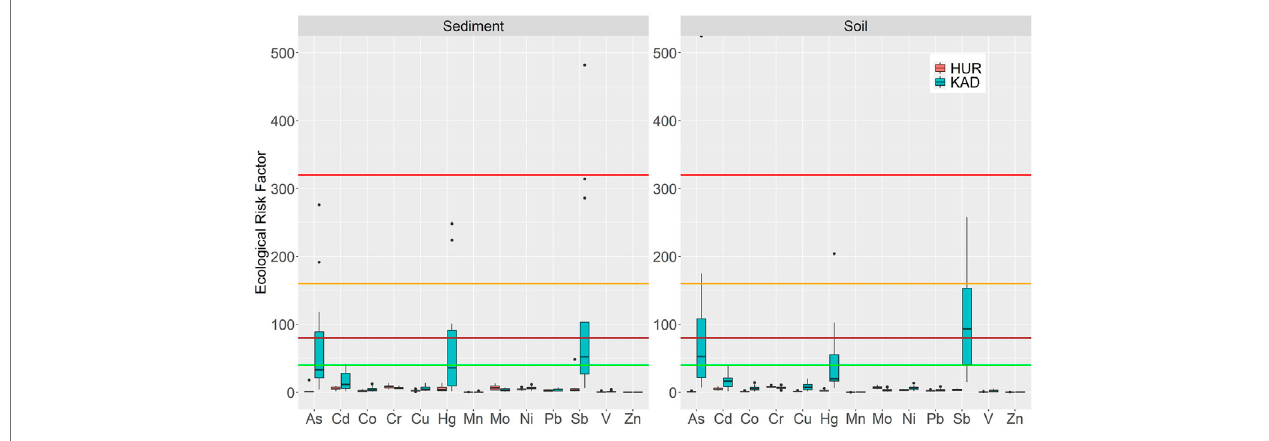
FIGURE 6 | Potential ecological risk factors for PHEs analysed in KAD and HUR sediments and soils. Intercepts are placed at 60, 80, 160, and 320 upper boundaries for low, moderate, considerable and high risk. Y-axis has been modi fi ed to max 500 so higher outliers in soil are